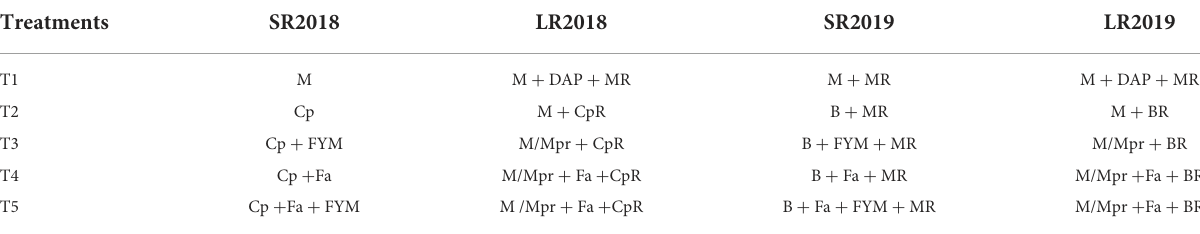
TABLE 1 Description of treatments in the four crop-growing seasons of 2018 and 2019.